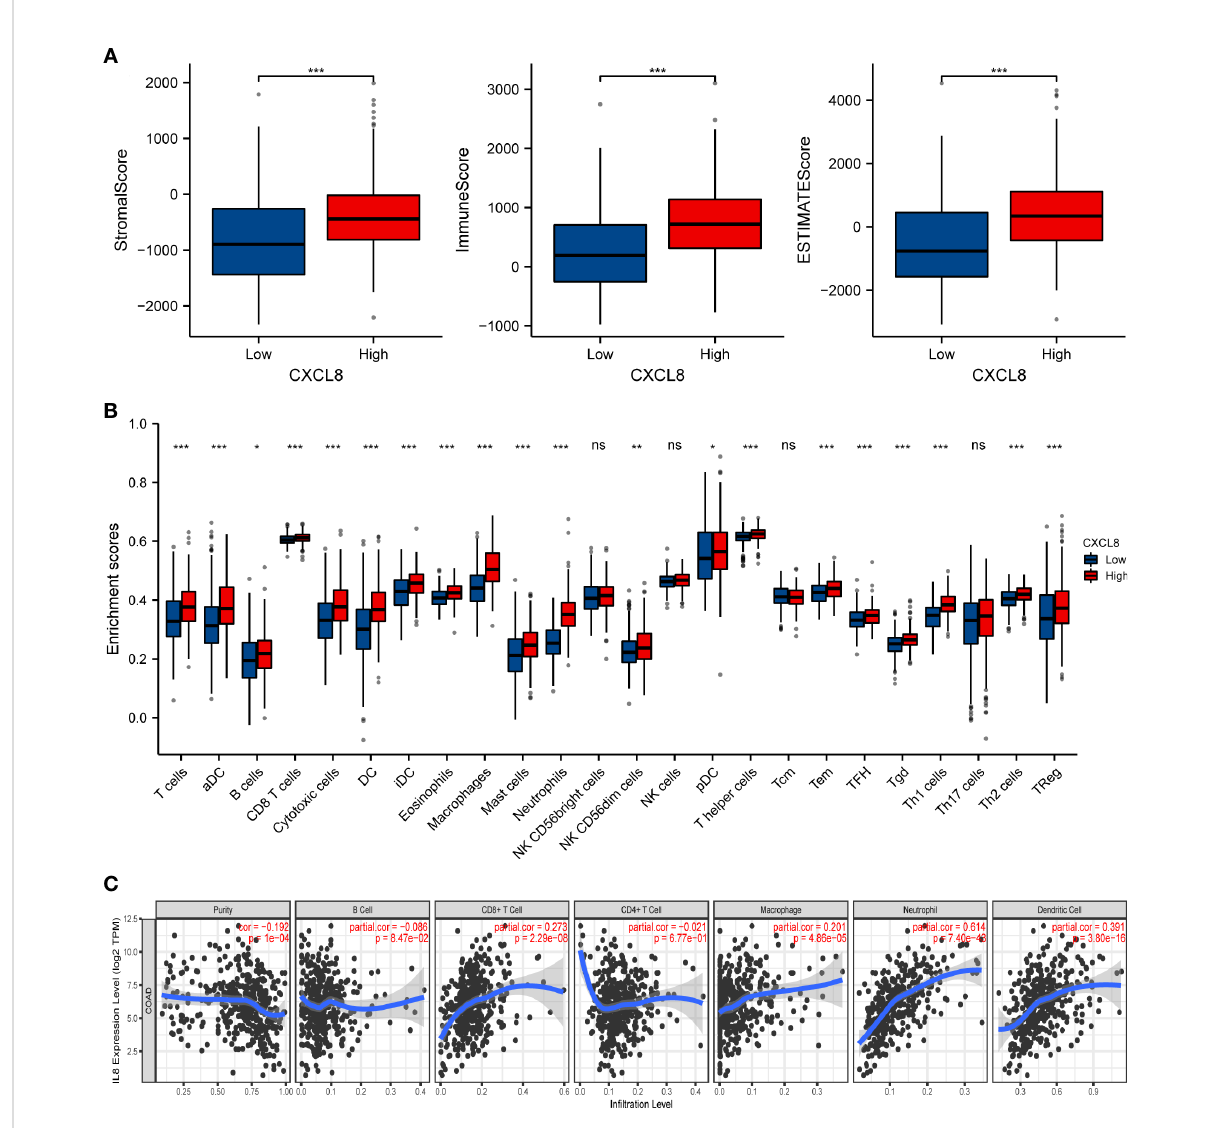
FIGURE 6 The relationship of immune cell in fi ltration with CXCL8 level in THCA. (A) The correlation of CXCL8 expression level with immune score, stromal score, as well as ESTIMATE score. (B) Relationships among in fi ltration levels of 24 immune cell types and CXCL8 expression pro fi les by ssGSEA. (C) Correlation of CXCL8 expression with immune in fi ltration level in CRC. * p < 0.05, ** p < 0.01, *** p <